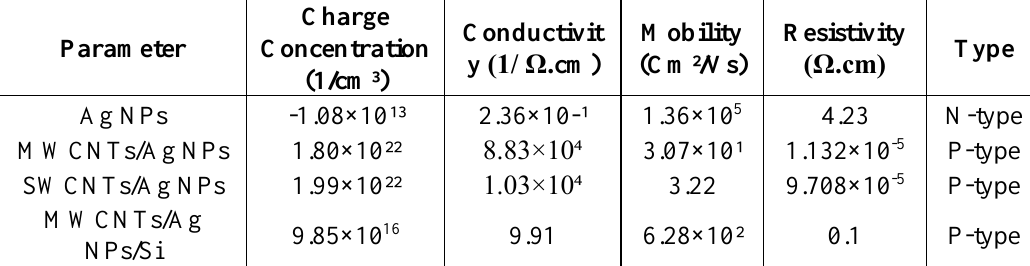
Figure 8b: FESEM images of SWCNTs/Ag NPs (right) and for MWCNTs/Ag NPs (left). Table 1: Hall measurement parameters.